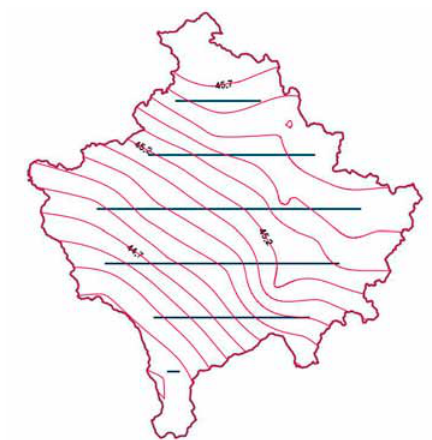
Fig. 7. Final Kosovo geoid model determined by DFHRS